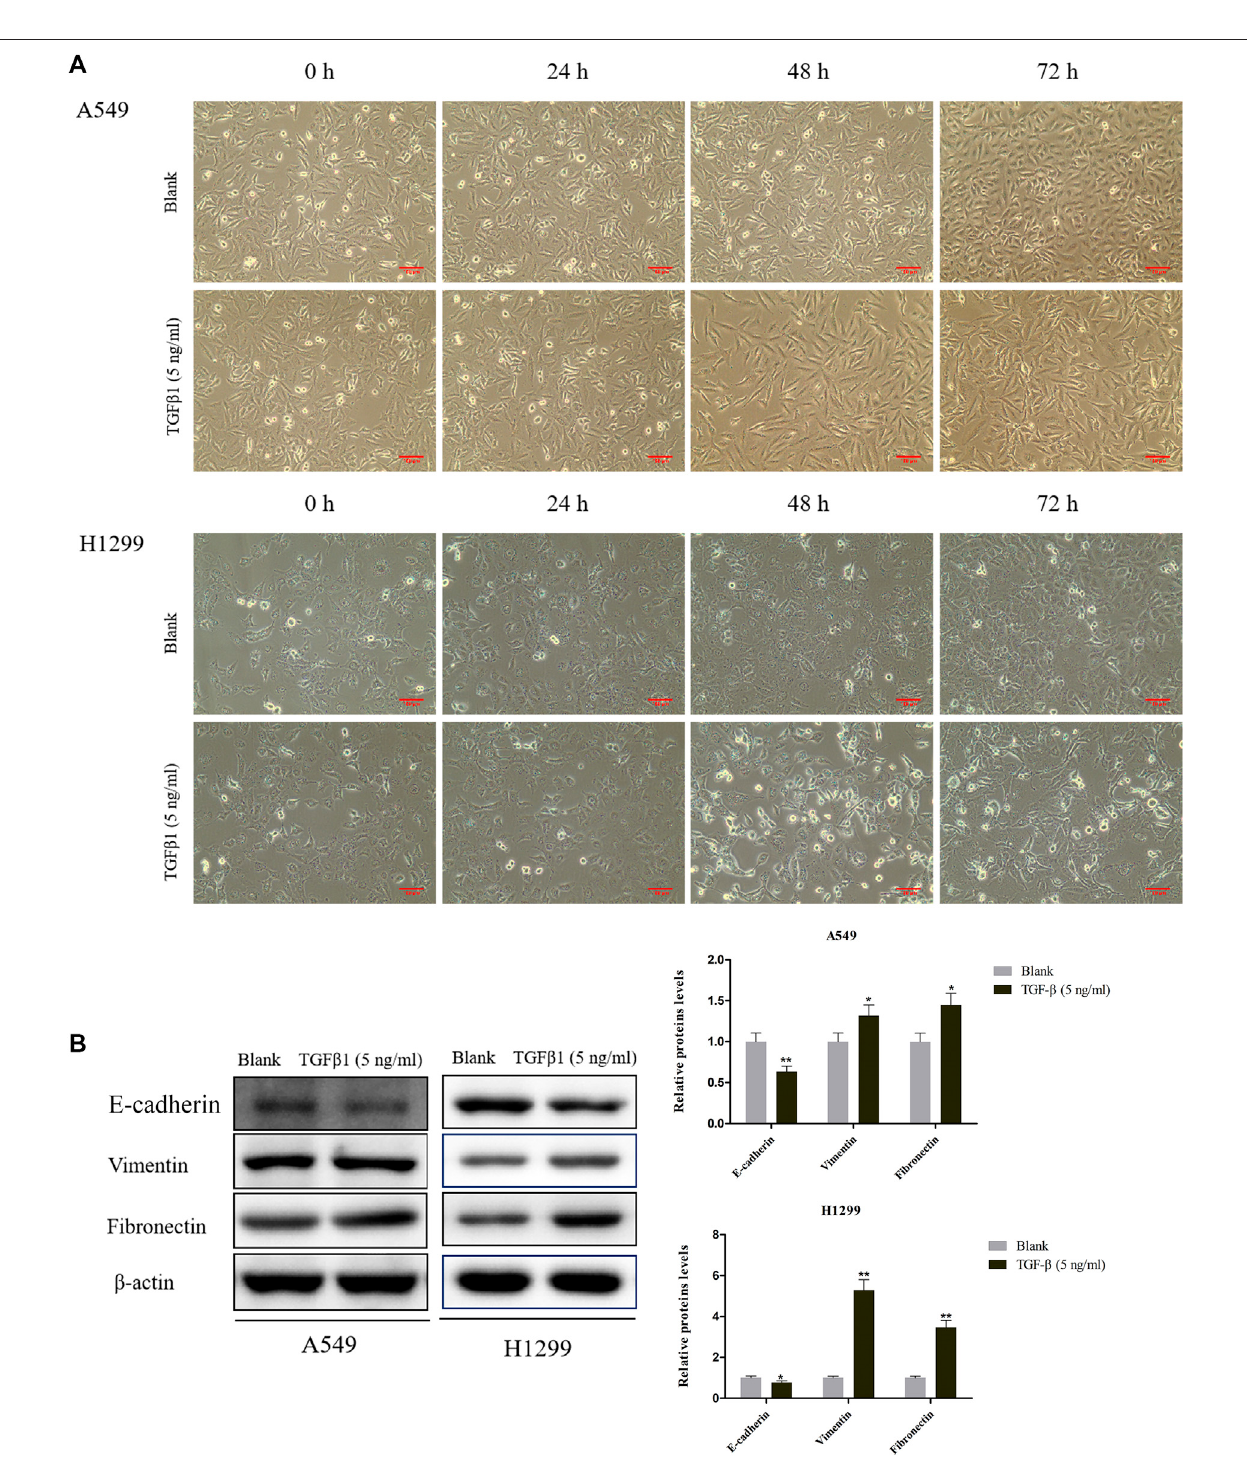
FIGURE 2 | Effects of TGF- β 1 on cell morphological changes and epithelial-mesenchymal transition of A549 and H1299 cells. (A) Microscopic photo of the lung cancer cells A549 and H1299 that treated with transforming growth factor- β 1 (TGF- β 1, 5 ng/ ml) for 0 h, 24, 48, and 72 h. (B) The levels of E-cadherin, Vimentin, and Fibronectin in A549 and H1299 cells treated with TGF- β 1 (5 ng/ ml) for 72 h, as determined by western blot. * p < 0.05, ** p < 0.01. versus the Blank group.